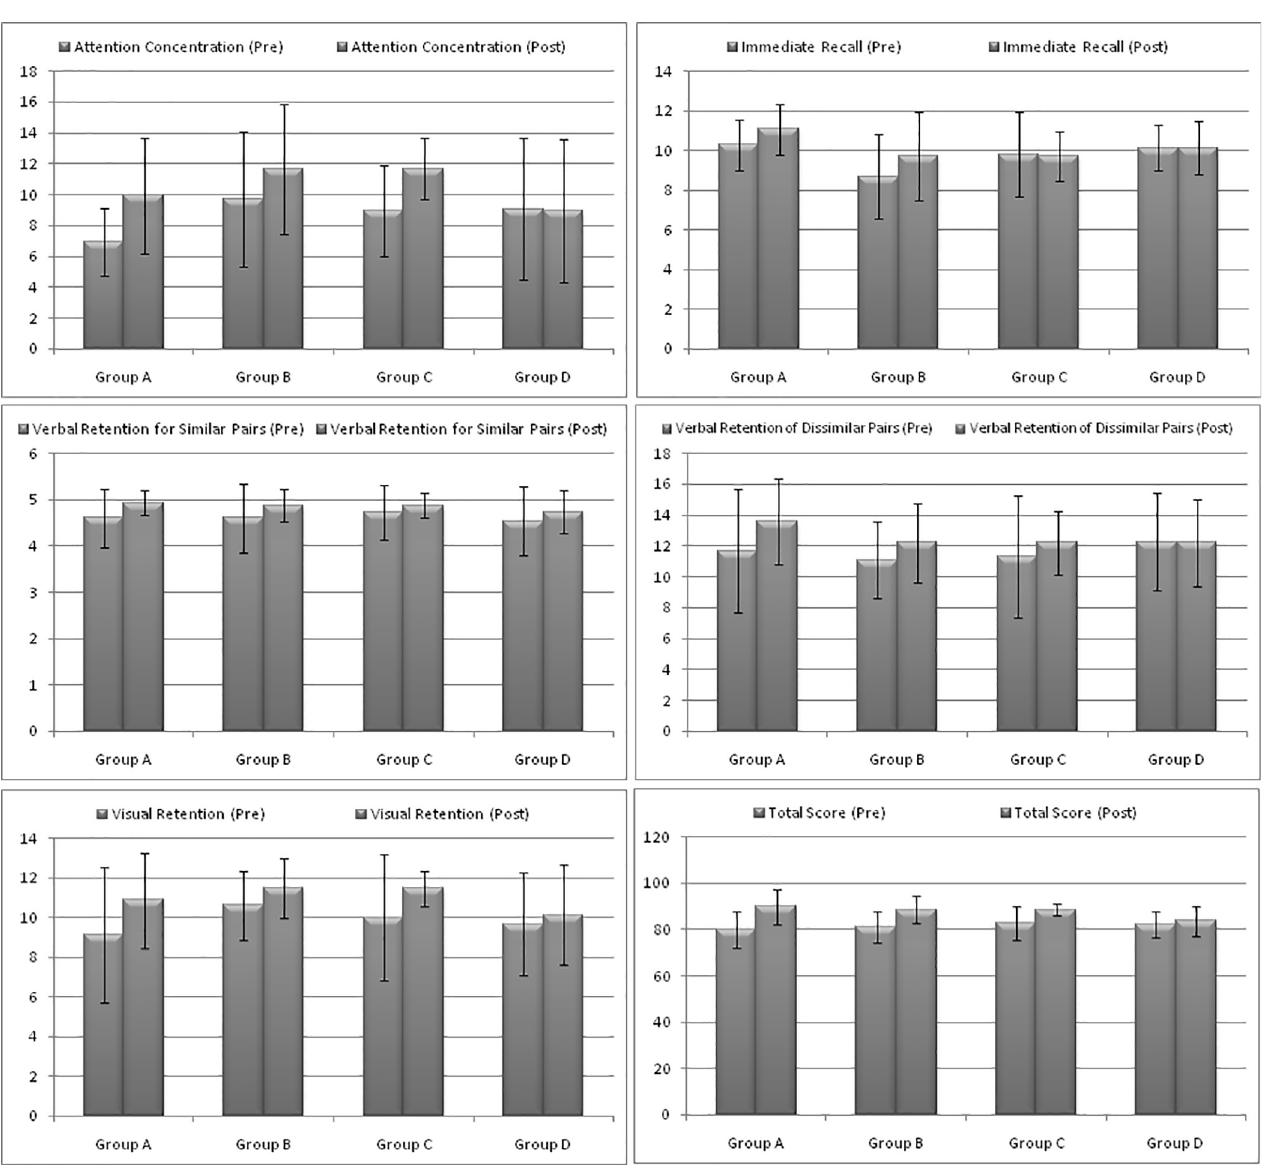
Fig 2. Average changes in cognitive functions from the baseline (Mean ±